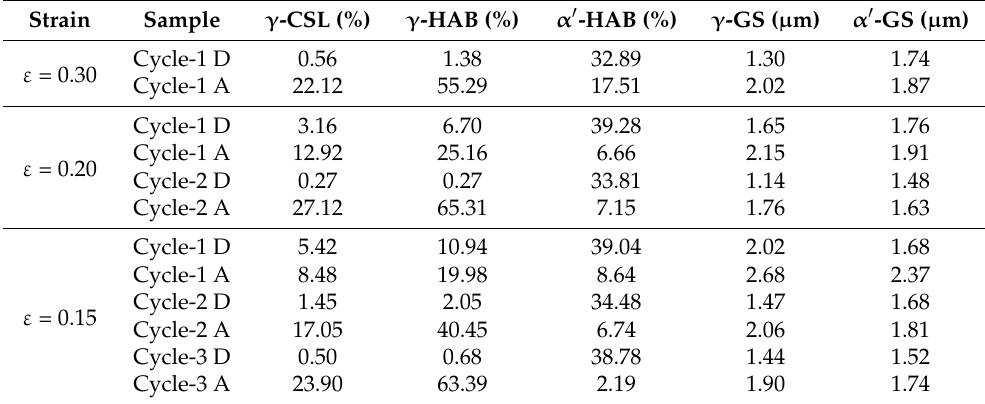
Table 4. Average grain size and grain boundary statistics for TMP